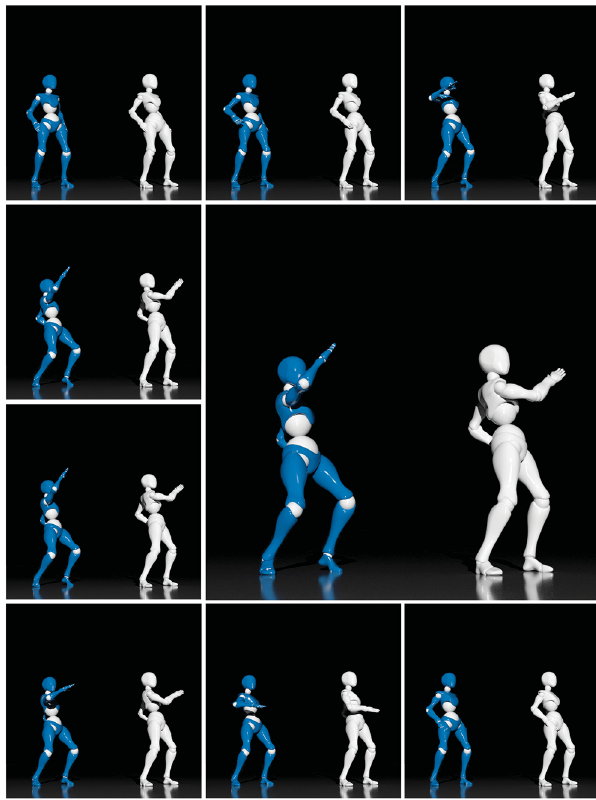
Fig. 18 Uniformly spaced frames extracted from a “Blocking” motion from Adobe’s Mixamo [48], before (right character in each panel) and after editing (left character) using our technique. The edits reposition the location of the right arm and also adjust the character’s centre of gravity. Also see the video in the